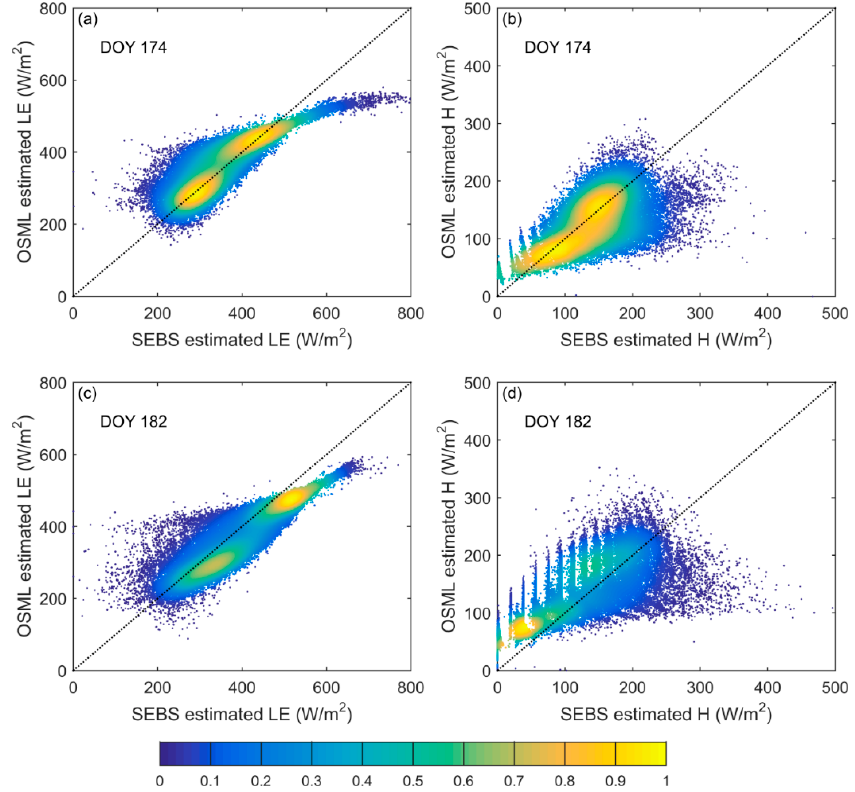
Figure 8. Comparison of OSML- and SEBS-derived LE on: DOY 174 ( a ); and DOY 182 ( c ); and comparison of OSML- and SEBS-derived H: on DOY 174 ( b ); and DOY 182 ( d ) (for cornfields and soybean fields only, color shading indicates pixel density).